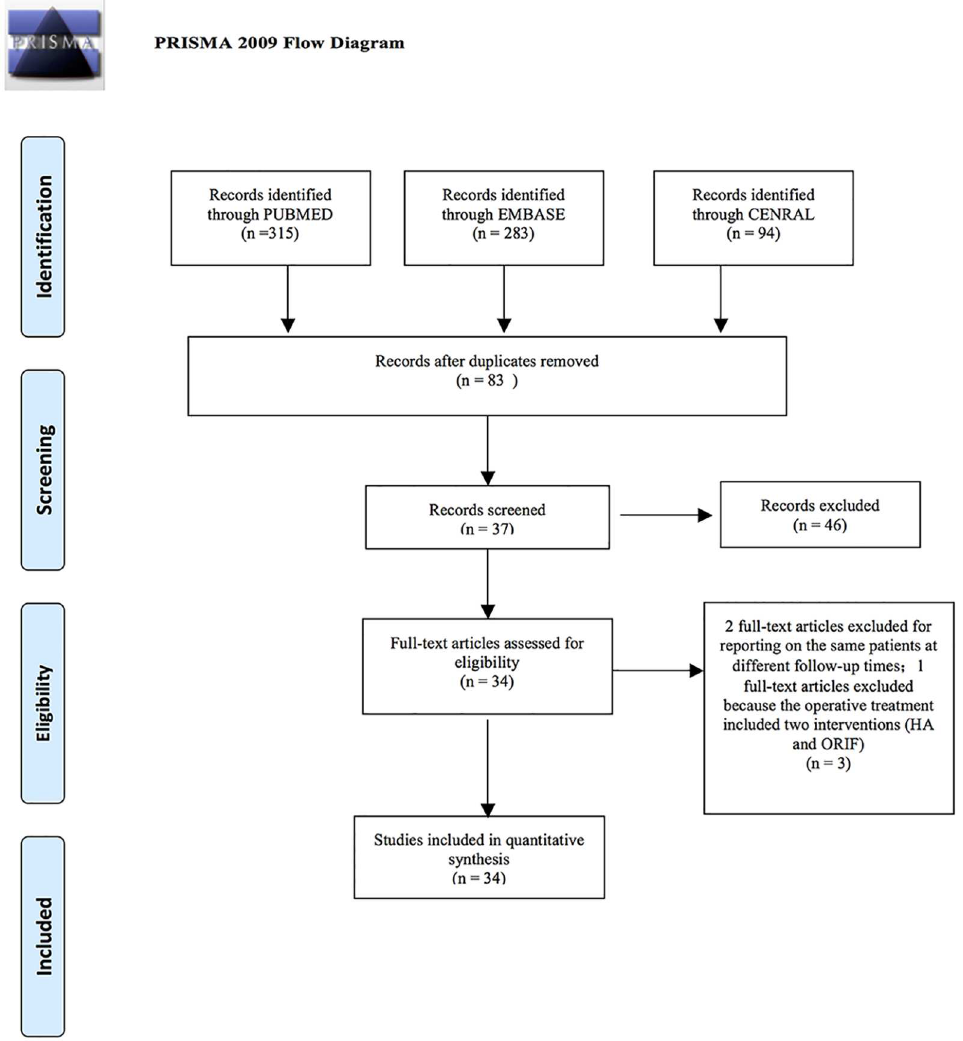
Fig 1. Flow chart of selection of studies for inclusion in meta- analysis. From : Moher D, LiberatiA, TetZlaff J, Altman DG, The PRISMA Group (2009). P referred R eporting I tems for S ystematic Reviewsand M eta- A nalyses:The PRISMA Statement. PLoS Med 6(7): e1000097.doi: 10.1371/journal.pmed1000097 For more information, visit